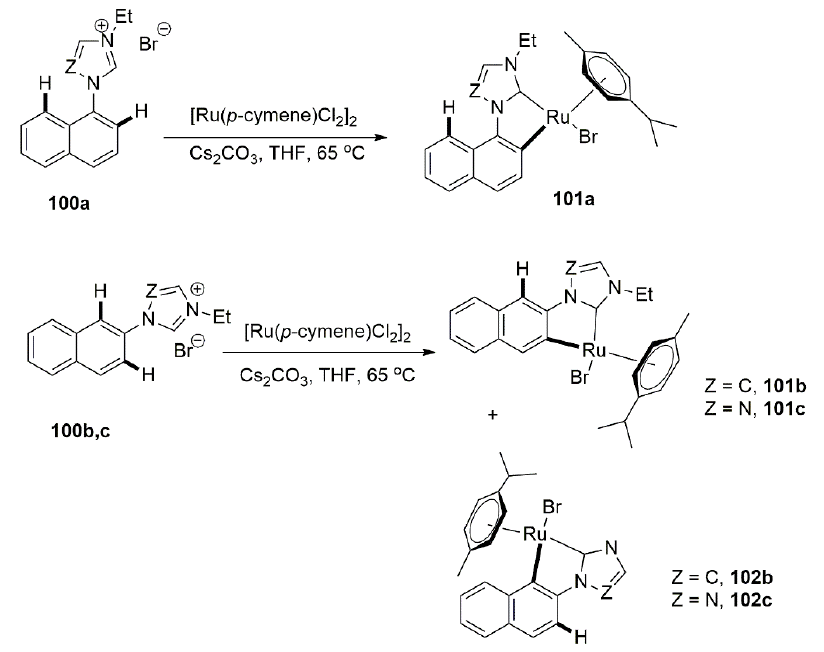
Scheme 25. Ru(II) complexes with NHC ‐ C ligands